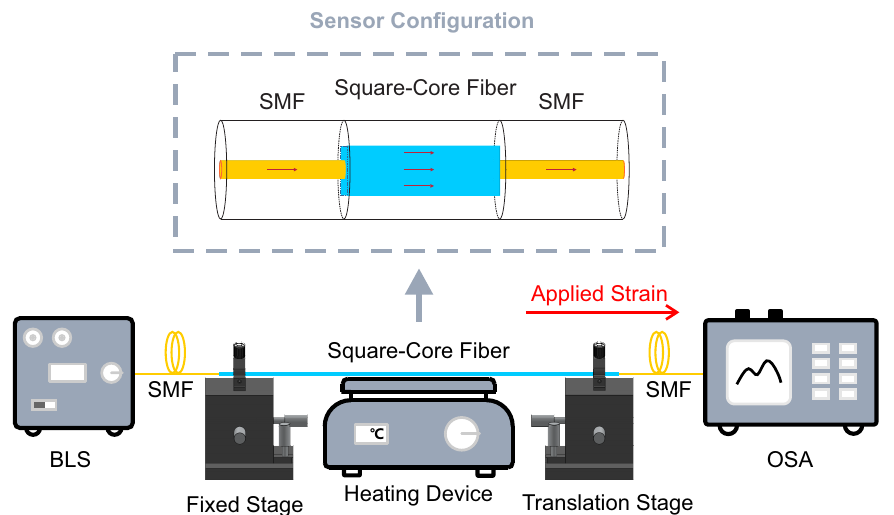
Figure 1. Schematic diagram of the experimental setup for temperature and strain measurement. The insert shows the schematic diagram of the fiber sensor; BLS, broadband light source; SMF, single-mode fiber; OSA, optical spectrum analyzer.